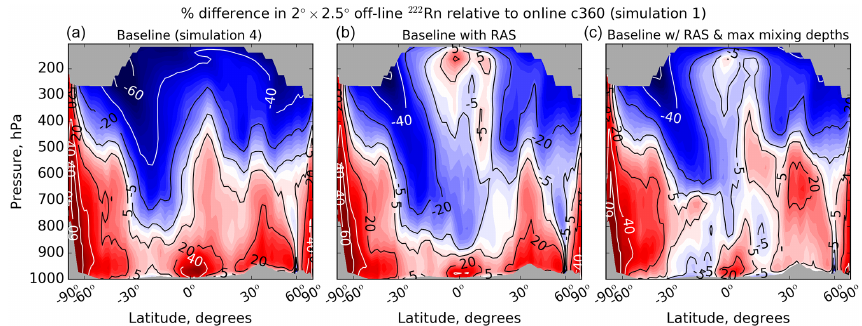
Figure 6. Errors in off-line coarse-resolution (2 ◦ × 2.5 ◦ ) simulations of 222 Rn concentrations relative to the reference online c360 GEOS-5 simulation (simulation 1). Values are percentage differences in zonal mean concentrations for July 2013. (a) Errors for the baseline 2 ◦ × 2.5 ◦ GEOS-Chem simulation. (b) Errors for the same baseline but with adjusted RAS convective mass fluxes (see text). (c) Errors for the same baseline with adjusted RAS convective mass fluxes and maximum mixing depths for each coarse-resolution grid cell (cf. Fig. 9).